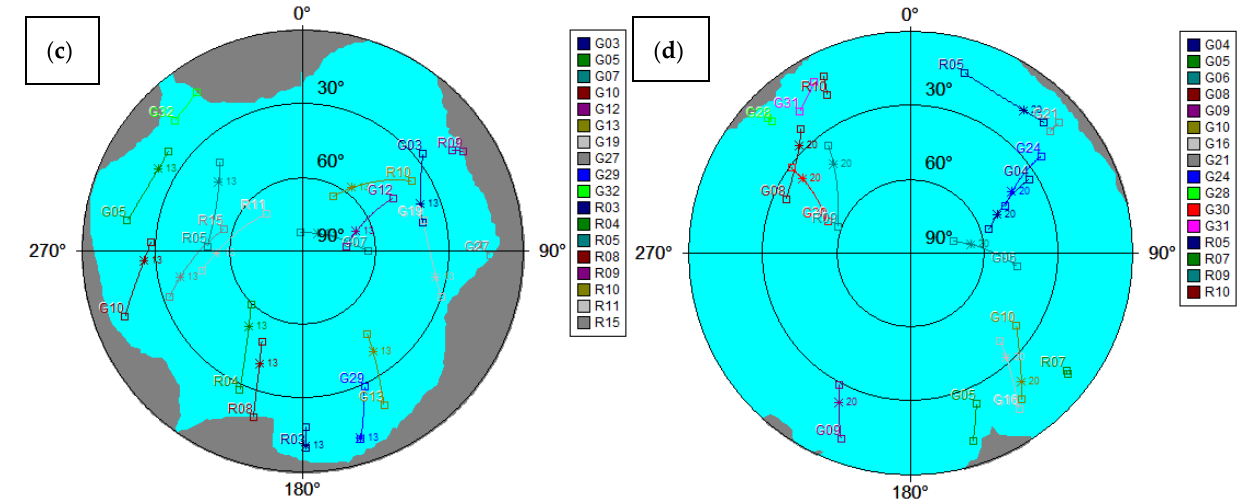
Figure 5. Sky visibility conditions during each part of the experiment: ( a ) surface, ( b ) line, ( c ) point, ( d ) static session.